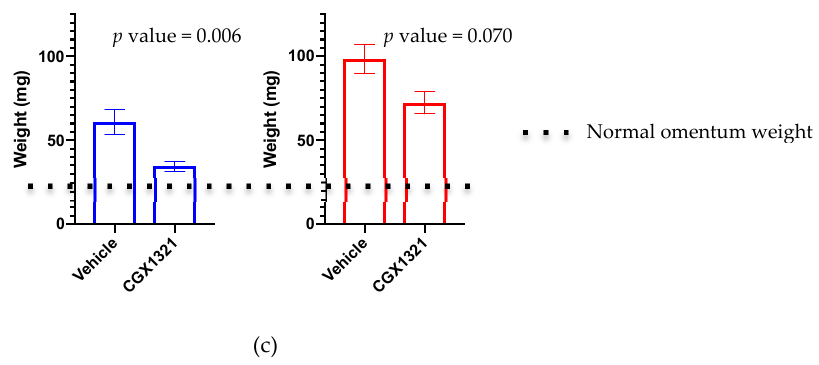
Figure 3. In vivo inhibition of Wnt signaling using CGX1321. ( a ) Scheme of the timeline for tumor challenge and treatment in C57Bl/6 mice for both cell lines. Mice were either then monitored for survival or sacrificed on Day 42. ( b ) Survival was increased with CGX1321 treatment in ID8 tumor challenge, but not tumor challenge with ID8p53 -/- . ( c ) Omentum weight had a statistically significant decrease with CGX1321 treatment after 42 days of tumor challenge with ID8, but not with ID8p53 -/- tumor challenge.